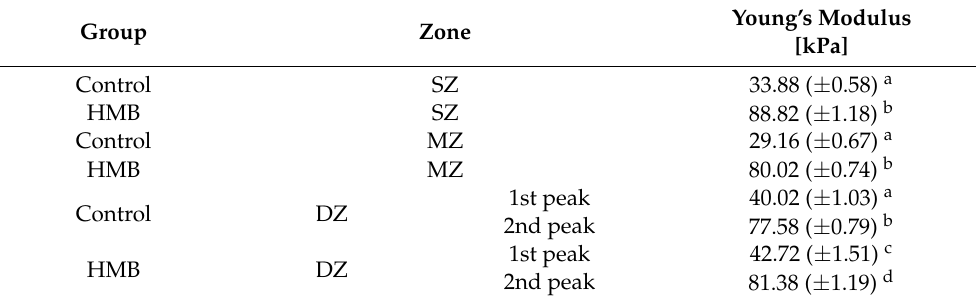
Figure 3. Height (I) and vertical deflection (II) images of AC zones with corresponding histograms of Young’s modulus distribution (III) determined for SZ (panel A ), MZ (panel B ) and DZ (panel C ) with Gaussian functions fitted. Scale bars are equal to 2 μ m. HMB—supplemented group, SZ—superficial zone, MZ—middle zone, DZ—deep zone. Table 2. Values of Young’s modulus given as means ± SD. Statistically significant differences between groups (at p < 0.05) were signed by a , b , c and d